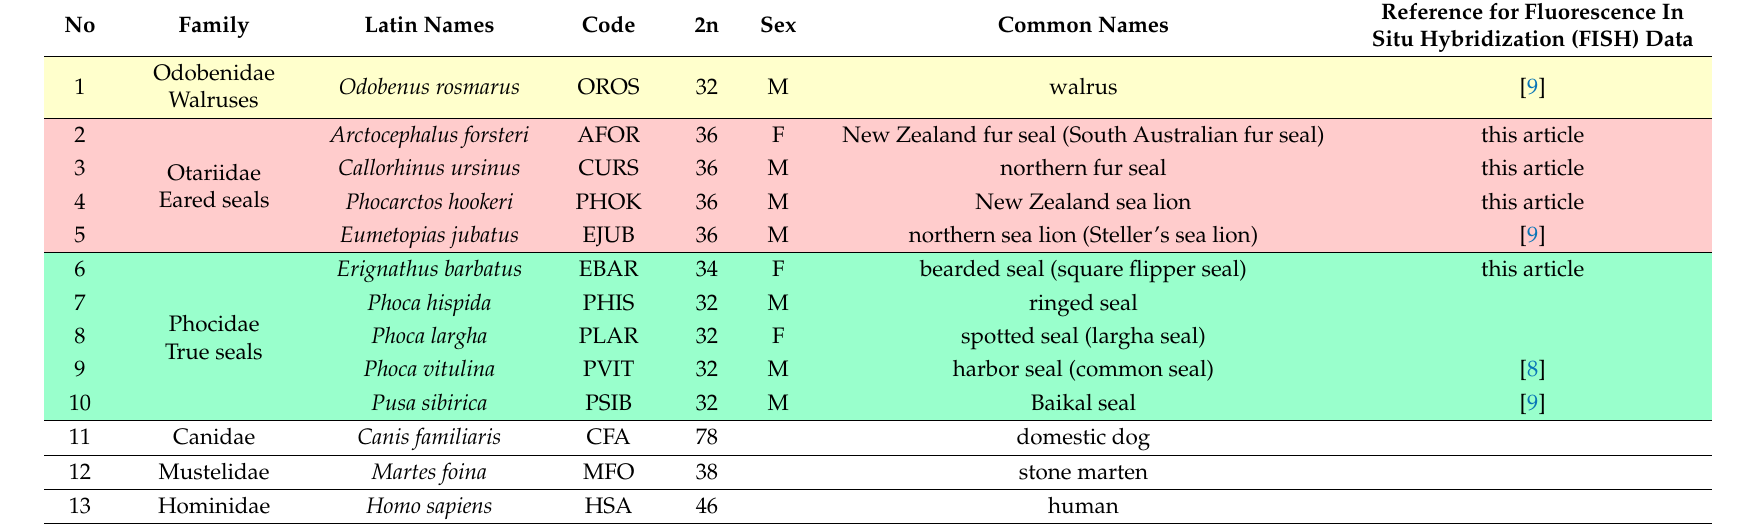
Table 1. Description of the species used in this